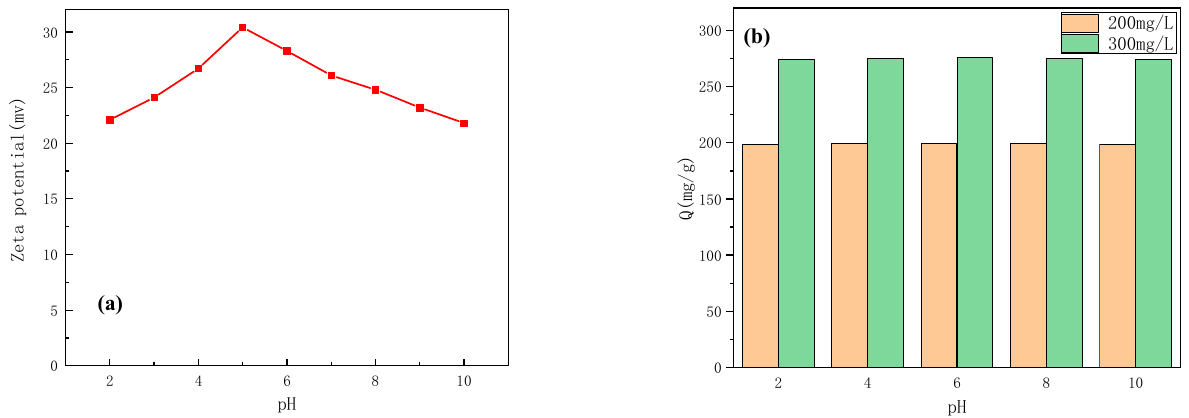
Figure 8. The zeta potential ( a ) and adsorption capacity ( b ) of γ -Fe 2 O 3 @GMA@IM at different pHs.